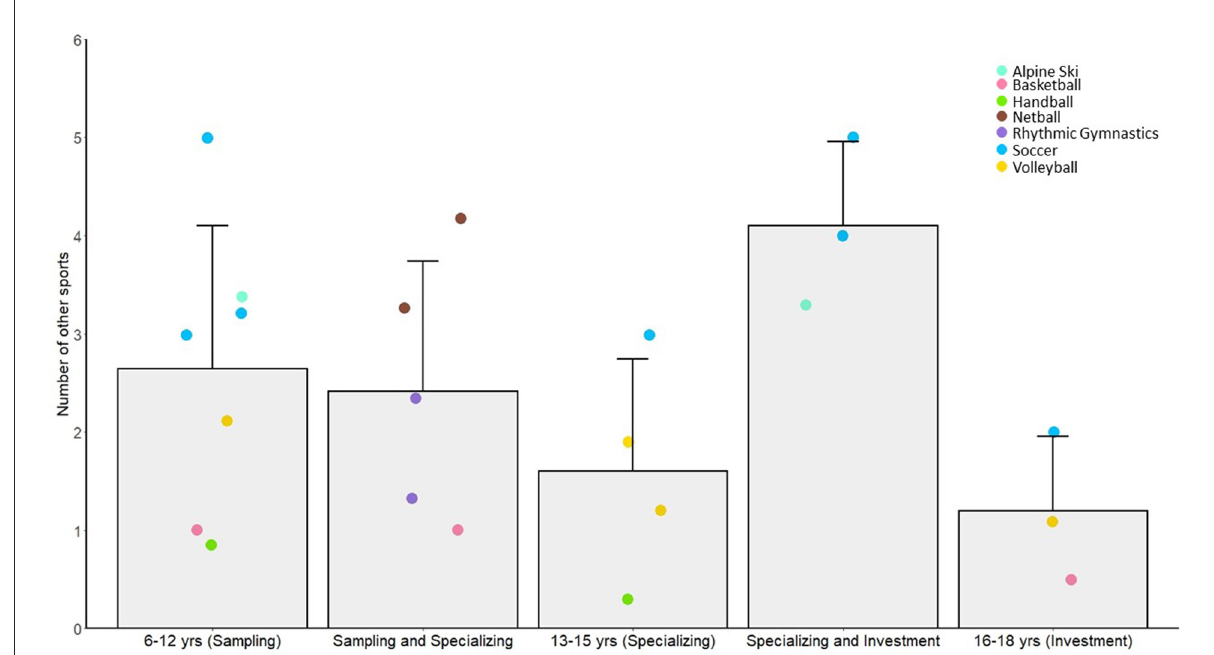
FIGURE4 Sample (bar) and individual study means (colored circles) across different age categories defined in past literature as the sampling, specializing and investment years, for the average number of other sports participated by athletes. Error bars represent sample SDs and individual colored data points represent different sports and